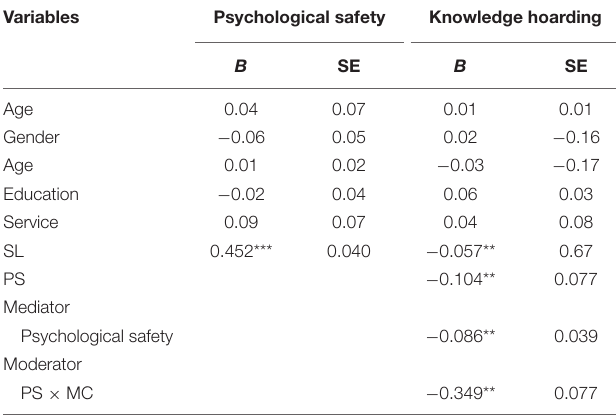
TABLE 5 | Regression results.